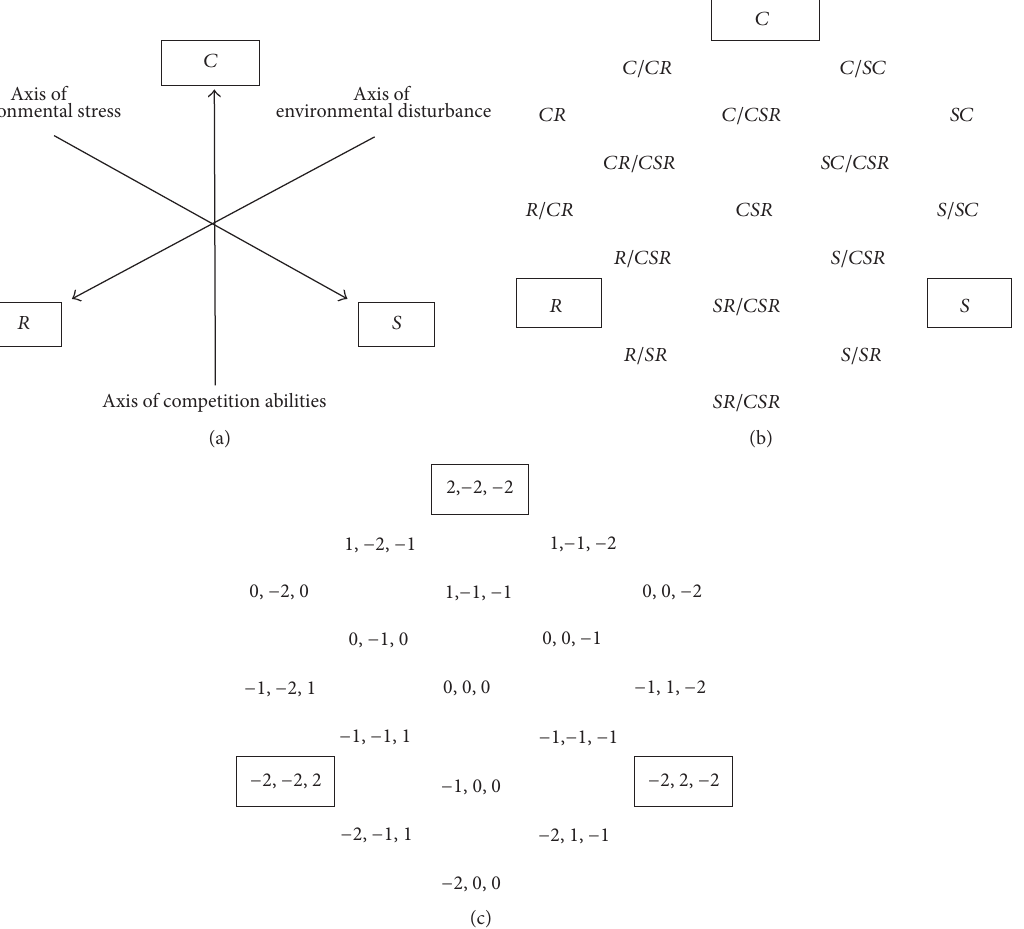
Figure 1: The basic classification of 𝐶𝑆𝑅 plant functional types [11]. (a) Main axes: 𝐶 axis of competition (ability of plants to displace the other species under favorable environmental conditions); 𝑆 axis of stress tolerance (ability to withstand long-term adverse environmental conditions); and 𝑅 axis of ruderality (ability to grow faster in disturbed sites). (b) Primary, secondary, and tertiary functional types (a total of 19 types). (c) Triple coordinates of the